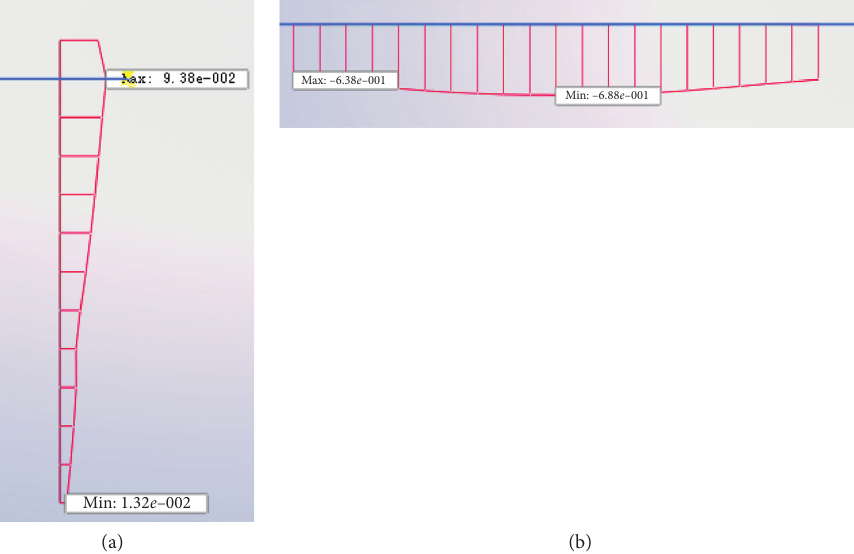
Figure 7: Calculation value of displacement of drainage plate: (a) PVDs and (b)